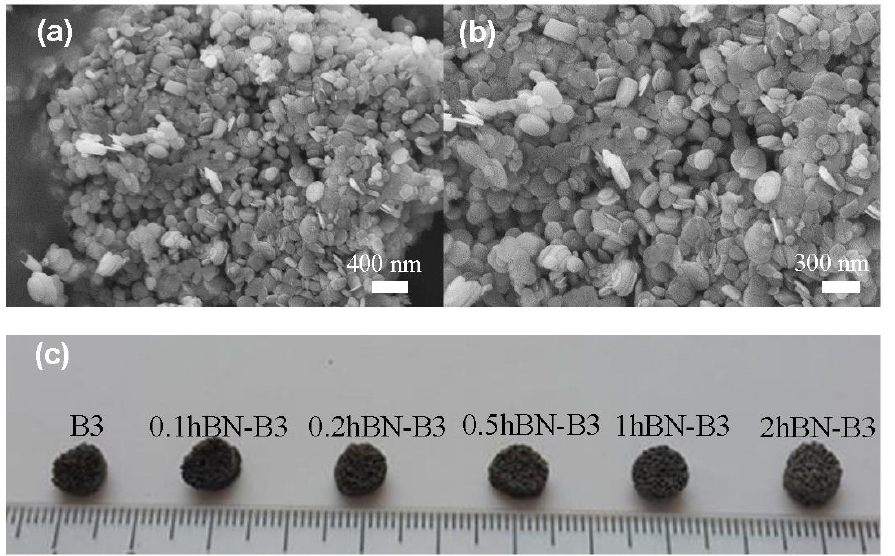
Figure 1. ( a , b ) SEM micrographs of the as-received hBN nanopowders; ( c ) digital image of the fabricated glass scaffolds.